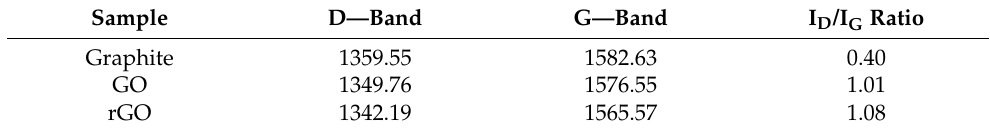
Table 3. D band, G band and D/G ratio from the Raman spectra of Graphite, GO and